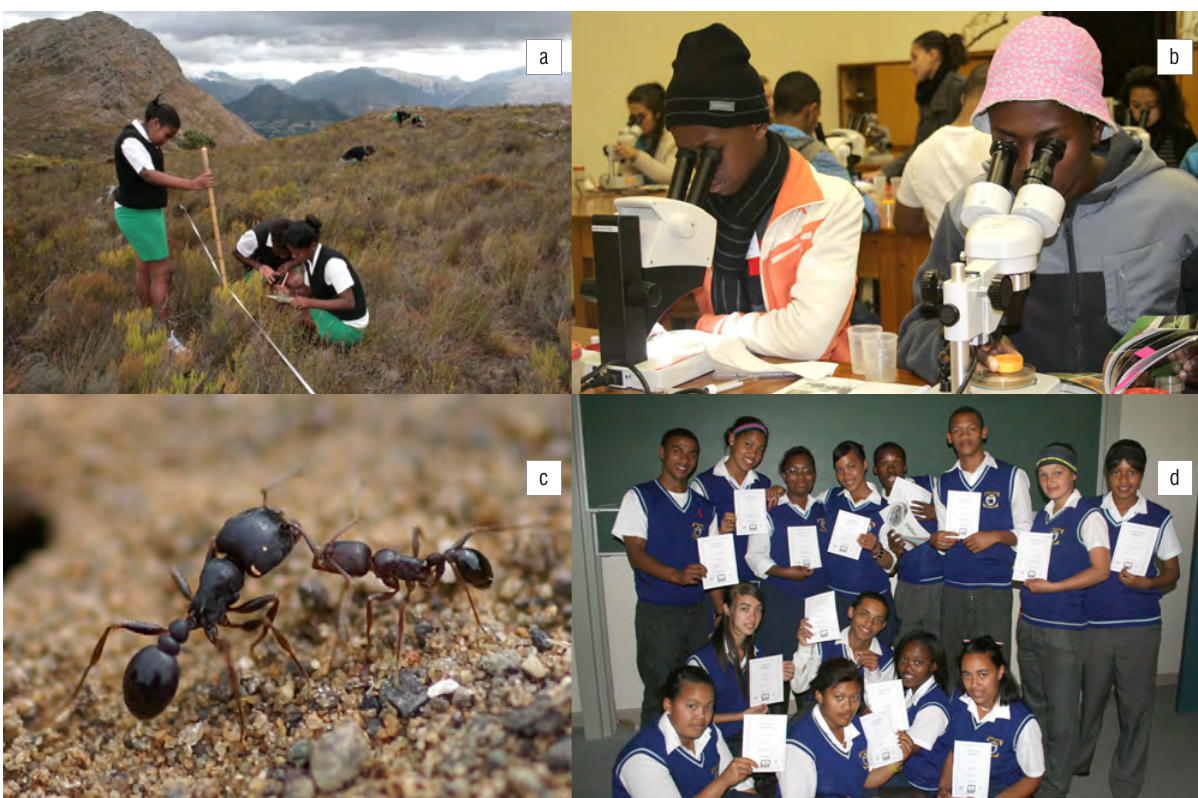
Figure 7: Participants in the C∙I∙B’s Iimbovane project, aimed at raising awareness of biodiversity and conservation issues among school pupils. (a) Gaining field experience while collecting ants along a fynbos transect, (b) gaining insights into taxonomic techniques while using identification keys and microscopes to identify specimens and (c) interactions between two ant species ( Tetramorium quadrispinosum and T. solidum ). Ants are common in the environment, easy to collect, and mostly completely harmless to humans. They thus provide an ideal way to teach the concepts and practice of biodiversity science. (d) Pupils are provided with certificates on completion of the